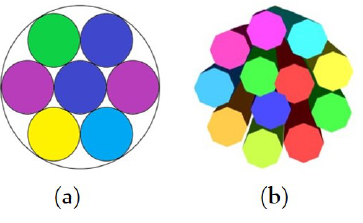
Figure 3. Arrangements with three fibres ( a ) and one fibre ( b ) at the centre. As shown in Figure 4, the smaller circles represent neighbouring fibres in a given layer and the radius of the bigger circle represents the radius of the yarn at the given layer. An isosceles triangle is drawn combining the centres of two smaller circles and the larger circle. If the number of fibres in the n th layer is N ,